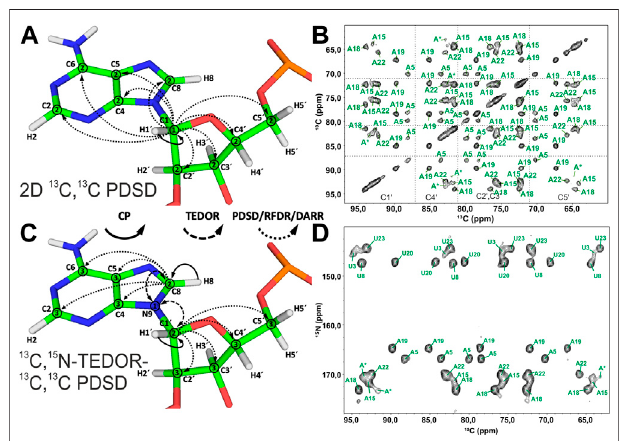
FIGURE 3 | Ribose assignment by 13 C-detected ssNMR. (A) Magnetizationtransferinhomonuclear 13 C, 13 Crecouplingexperiment(PDSD, DARR, and PAR) for the spin system – speci fi c assignment of carbon resonances in nucleotides shown on the example of an adenosine. (B) Zoom in on the ribose region of 13 C, 13 C PDSD spectra of the A lab -26mer box C/DRNAmeasuredatthemixingtimeof100 ms. (C) Magnetizationtransferin heteronuclear 13 C, 15 N-TEDOR- 13 C, 13 C PDSD experiment shown on the example of an adenosine. (D) Ribose region of the 13 C, 15 N-TEDOR- 13 C, 13 C PDSD spectrum of the A,U lab -26mer box C/D RNA measured at TEDOR and PDSD mixing times of 3.2 and 100 ms, respectively. In magnetization transfer schemes,solidarrowsindicateCPtransfers,dashedarrowsindicatedTEDOR transfer, and dotted arrows indicate homonuclear 13 C, 13 C recoupling; Arabic numbers correspondto thespectraldimensions(t 1 – t 3 ).The spectrumin (B) is adapted with permission from (Marchanka et al., 2013), © John Wiley and Sons, 2013. The spectrum in (D) is adapted from (Marchanka et al.,